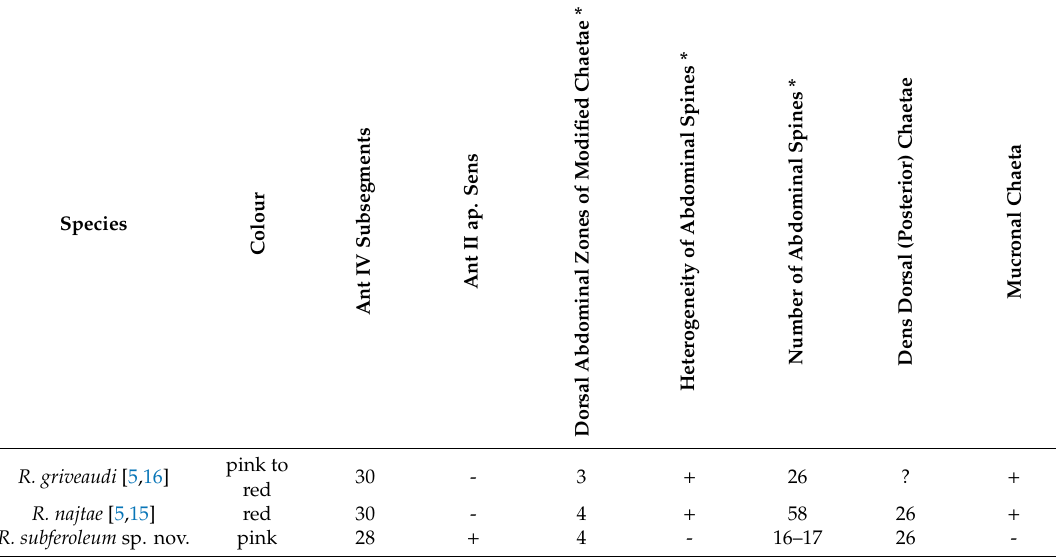
Table 1. Main characters of Richardsitas